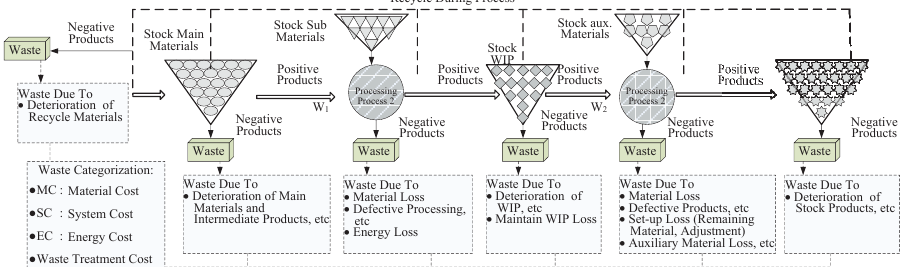
Fig. 1. The concept of MFCA 3